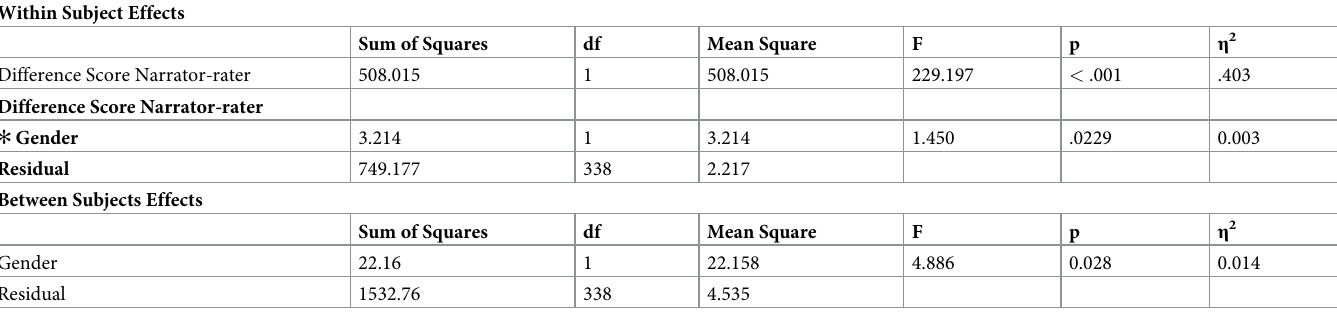
Table 2. ANOVA tables for difference score between narrator and rater by type of violence, Phase 2. Within Subject